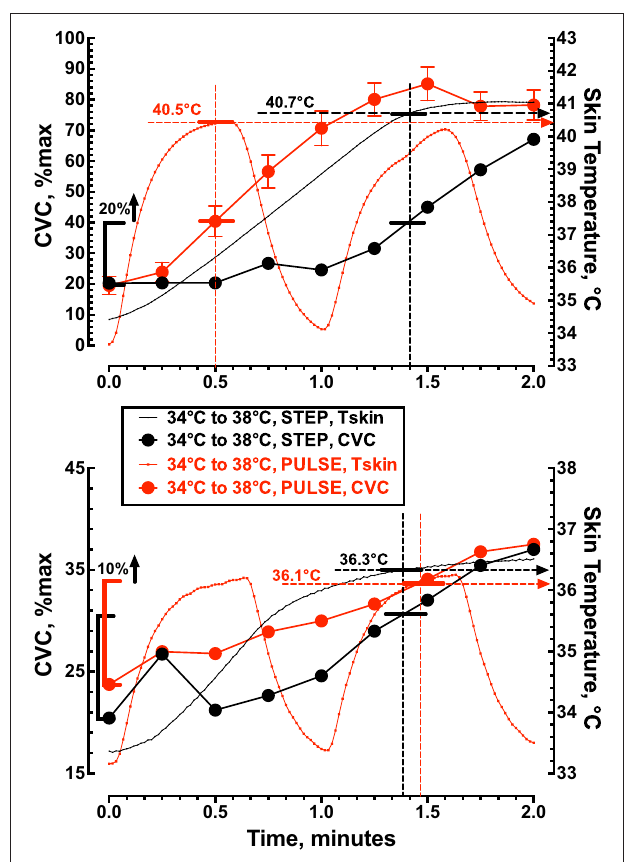
FIGURE 5 | The relationship between cutaneous vascular conductance and local skin temperature during the first 2min of local skin heating. The top panel compares a single step change in local skin temperature from 34 to 42 ◦ C ( n = 10) with pulsed heating of 1 pulse per min, 34 to 42 ◦ C, rate of change = 1.0 ◦ C • s − 1 , 50% duty cycle ( n = 9). The lower panel compares a single step change in local skin temperature from 34 to 38 ◦ C ( n = 10) with pulsed heating of 1 pulse per min, 34 to 38 ◦ C, rate of change = 1.0 ◦ C • s − 1 , 50% duty cycle ( n = 10). Values represent the mean while the error bars have not been displayed to allow visualization of the